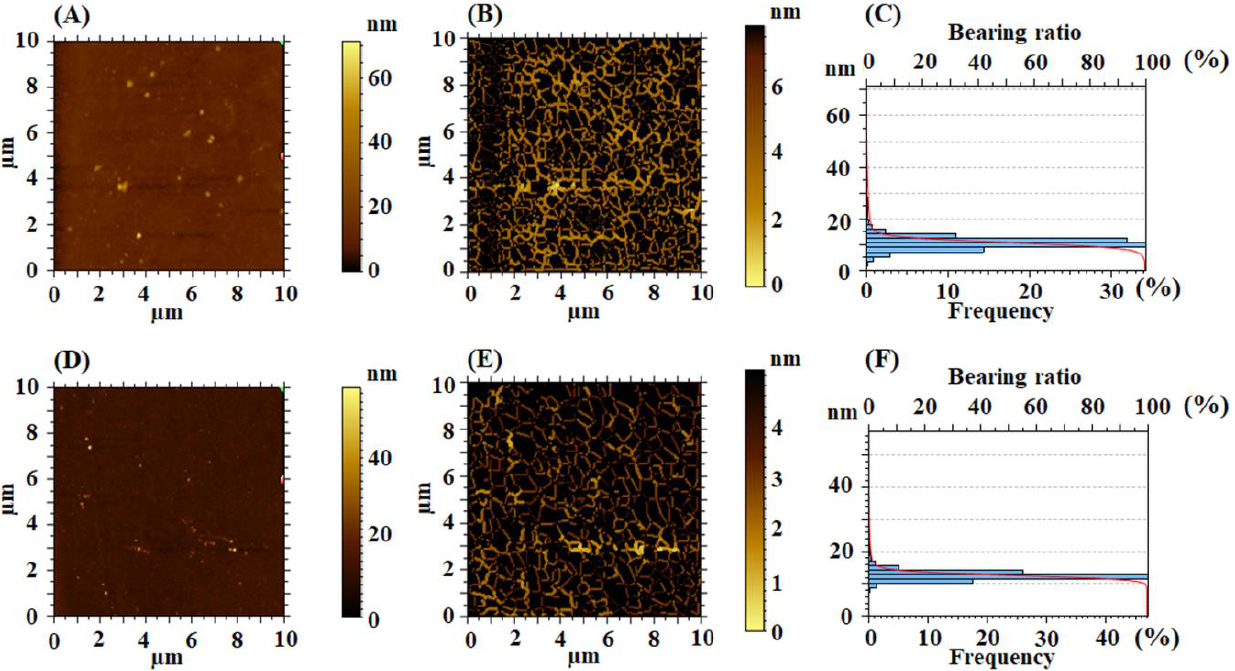
Figure 4. 2D topographical images, furrow maps and histograms/Abbott curves obtained for pristine